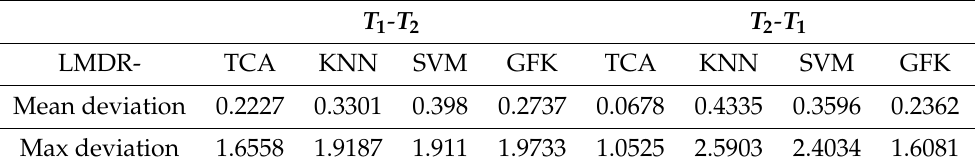
Figure 11. Localization performance of the different methods ( T 2 - T 1 ). Table 1. Localization errors of the different methods.